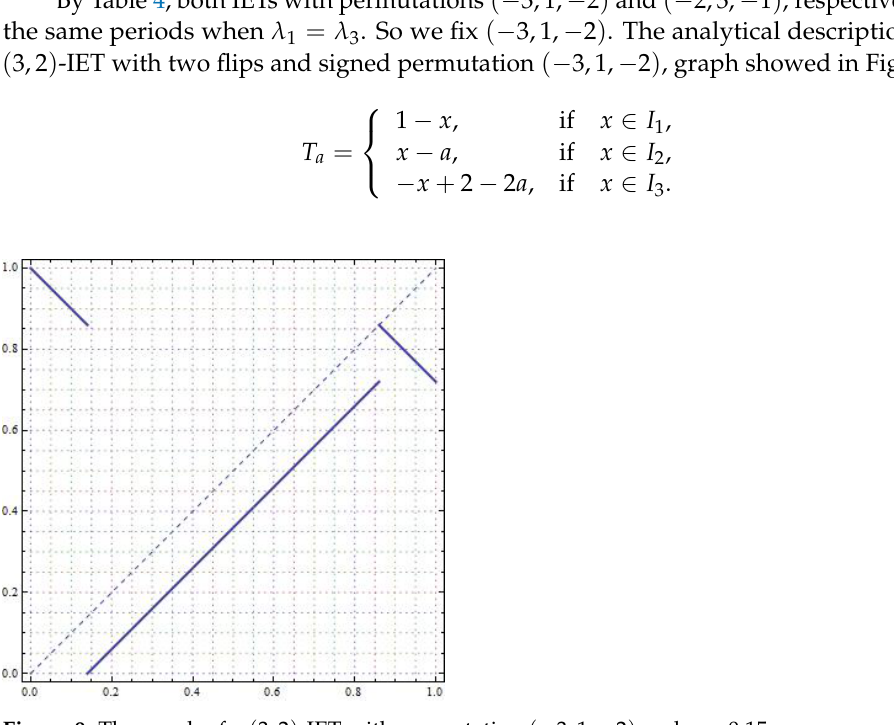
Figure 9. The graph of a ( 3,2 ) -IET with permutation ( − 3,1, − 2 ) and a =